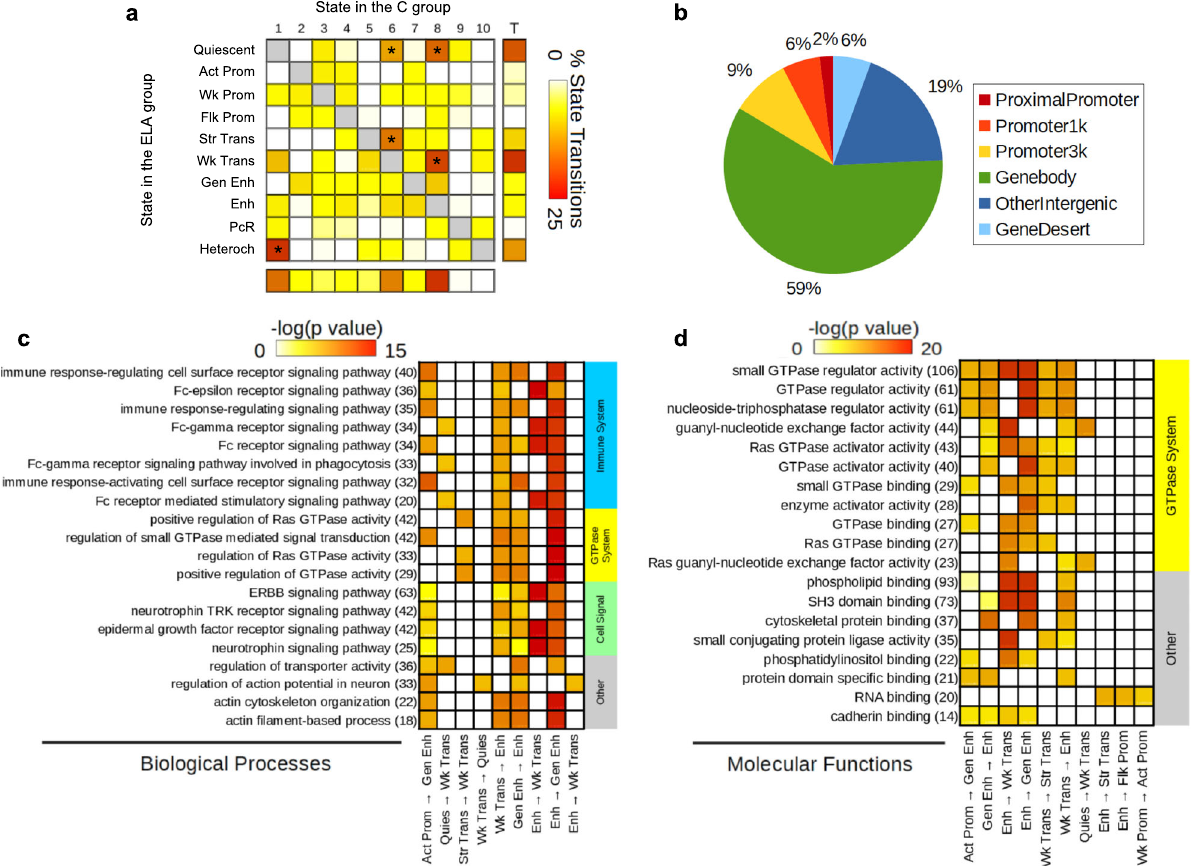
Fig. 4 Analysis of genomic sites showing a switch between chromatin states as a function of early-life adversity (ELA). a Percentage of each state transition (ST) type relative to the total number of transitions. For the healthy control (C) versus ELA group comparison, the cumulative percentages of ST from a speci fi c state to any other state are shown in the “ Total ” and “ T ” rows/columns. * indicates most frequent STs (see main text). b Distribution of ST localizations relative to genomic features, assessed using region_analysis 34 (see “ Methods ” ). c , d Gene ontology “ Biological Processes ” ( c ) or “ Molecular Functions ” ( d ) terms signi fi cantly associated with at least three types of ST (for each ST type, each GO term met the following criteria: fold change ≥ 1.5 and FDR-q ≤ 0.1, for both hypergeometric and binomial tests). Terms are grouped based on the overall system involved and ranked by co-occurrence score (in parentheses after each term), which re fl ects both their signi fi cance and their recurrence across multiple ST (see main text and ref. 35 ). Individual binomial P values for each type of ST and each term are shown by the color gradient. Immune-related and small GTPase terms were most strongly affected, across multiple ST. Of note, a complementary GREAT pathway analysis using MSigDB further strengthened these fi ndings by revealing recurrent enrichment of the integrin signaling pathway (across six types of ST, as well as for H3K27ac down DS; see Supplementary Fig. 12c), which is known to interact extensively with small GTPases 98 . Act-Prom active promoter, Enh enhancer, Flk-Prom fl anking promoter, Heterochr heterochromatin, PcR polycomb repressed, Str-Enh strong enhancer, Str-Trans strong transcription, Wk-Prom weak promoter, Wk-Trans weak transcription. Source data are provided as a Source Data fi